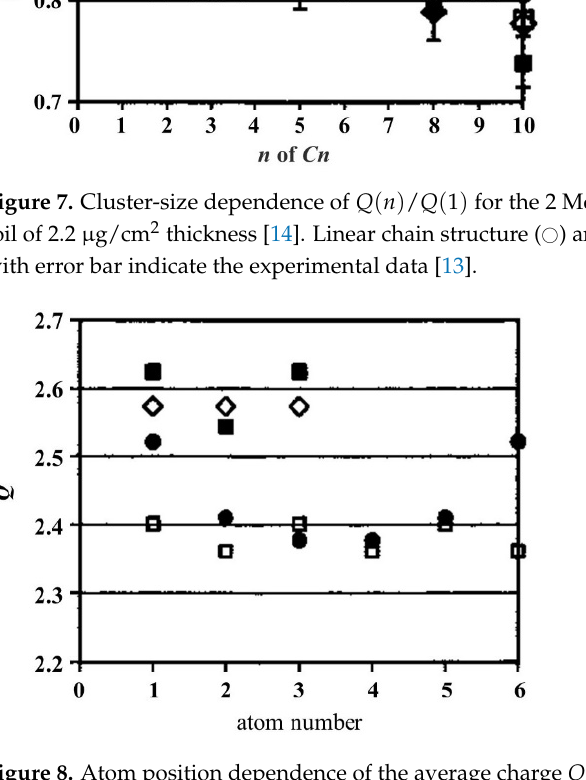
Figure 8. Atom position dependence of the average charge Q of constituent ions in the 2 MeV/atom C n ( n = 3,6 ) ions, traversing carbon foil of 2.39 µ g/cm 2 thickness. Linear chain ( (cid:4) for n = 3; • for n = 6) and ring structure ( for n = 3; (cid:3) for n = 6)